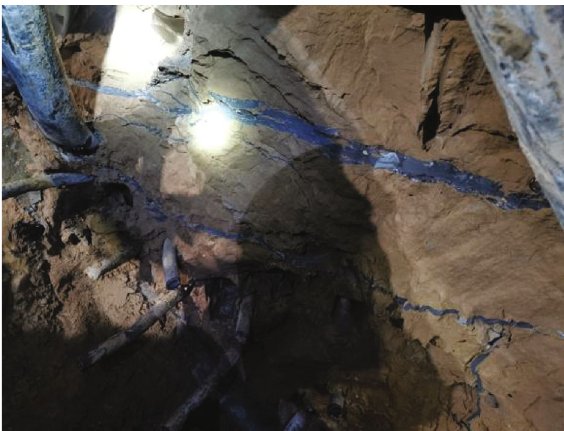
Figure 15: Grouting pulp